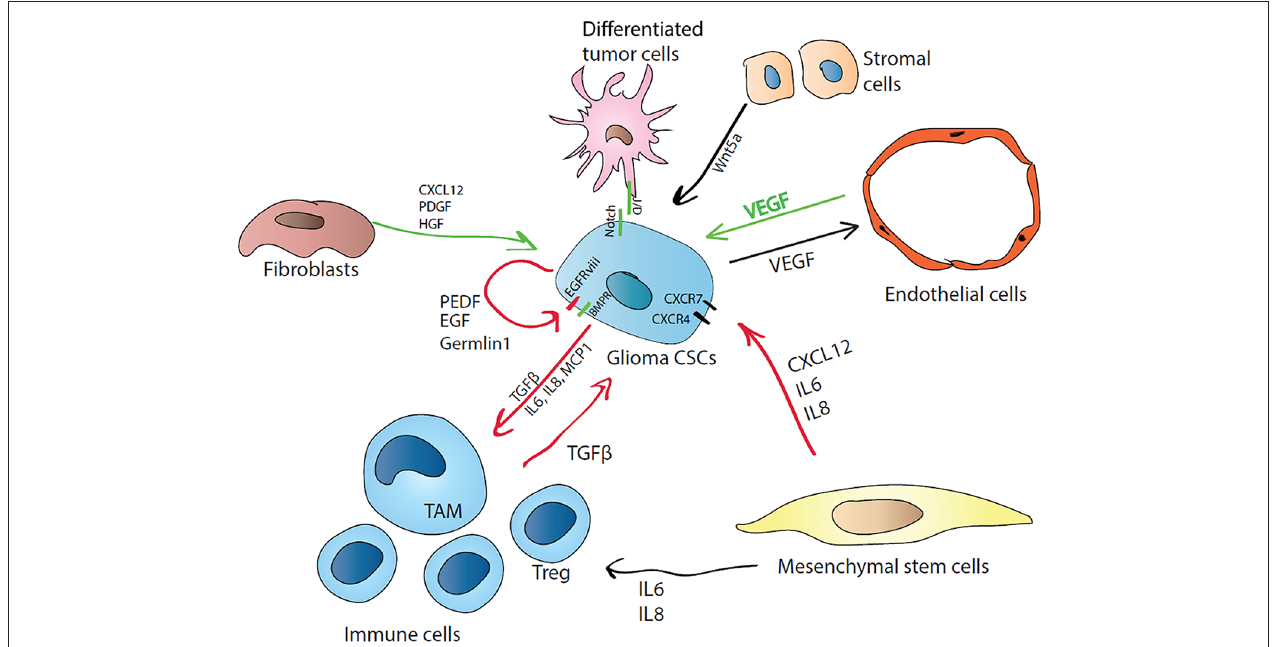
FIGURE 3 | Cellular and molecular regulators of glioma CSC quiescence in the niche. CSCs can regulate their own state by autocrine mechanism by producing differentiation antagonists (Germlin1) or poise themselves to active growth by synthesizing PEDF and EGF, or by expressing constitutively active form of EGFR (EGFRviii). CSCs can attract immune cells by releasing proinflammatory cytokines (MCP1 for monocytes, IL6 and IL8) and induce their immunosuppressive phenotype (M1 macrophages transform into tumor-associated macrophages (TAMs), effector T cells are induced to T regulatory cells (T regs)) by producing TGF β . In turn, induced tumor-associated immune cells favor the CSC state by producing TGF β . Mesenchymal cells CXCL12 can activate PI3K/Akt, IP3 and mitogen activated protein kinase (MAPK) pathways via CXCR4 and PLC/MAPK pathway via CXCR7. IL-8 supports glioma CSCs growth and migration towards endothelial cells. CSCs also regulate their nutrition supply by inducing neo-vascularization via vascular endothelial growth factor (VEGF) production. Stromal cells producing Wnt5a can induce CSC quiescence via Ryk receptor. Differentiated tumor cells can regulate CSCs state via cell-cell contact through Notch